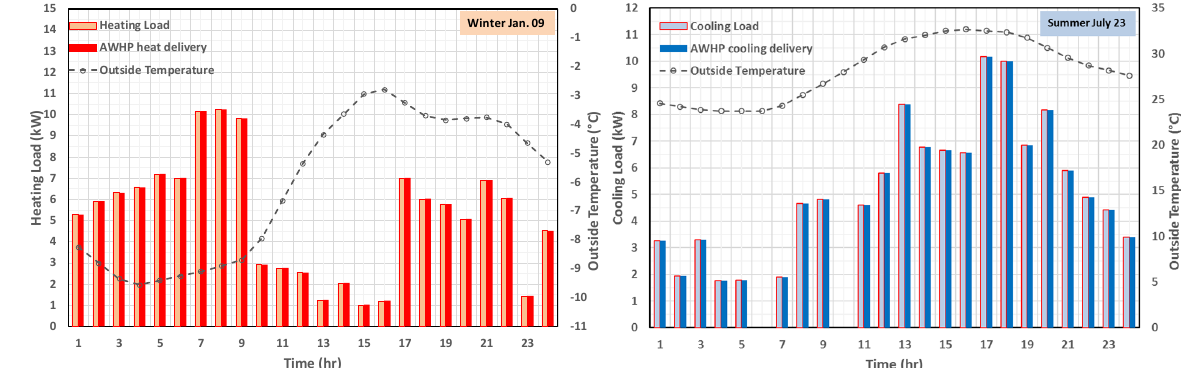
Figure 5. Hourly heating/cooling demand load and AWHP heat delivery for hybrid trigeneration system in warmest and coldest days under optimum design conditions.